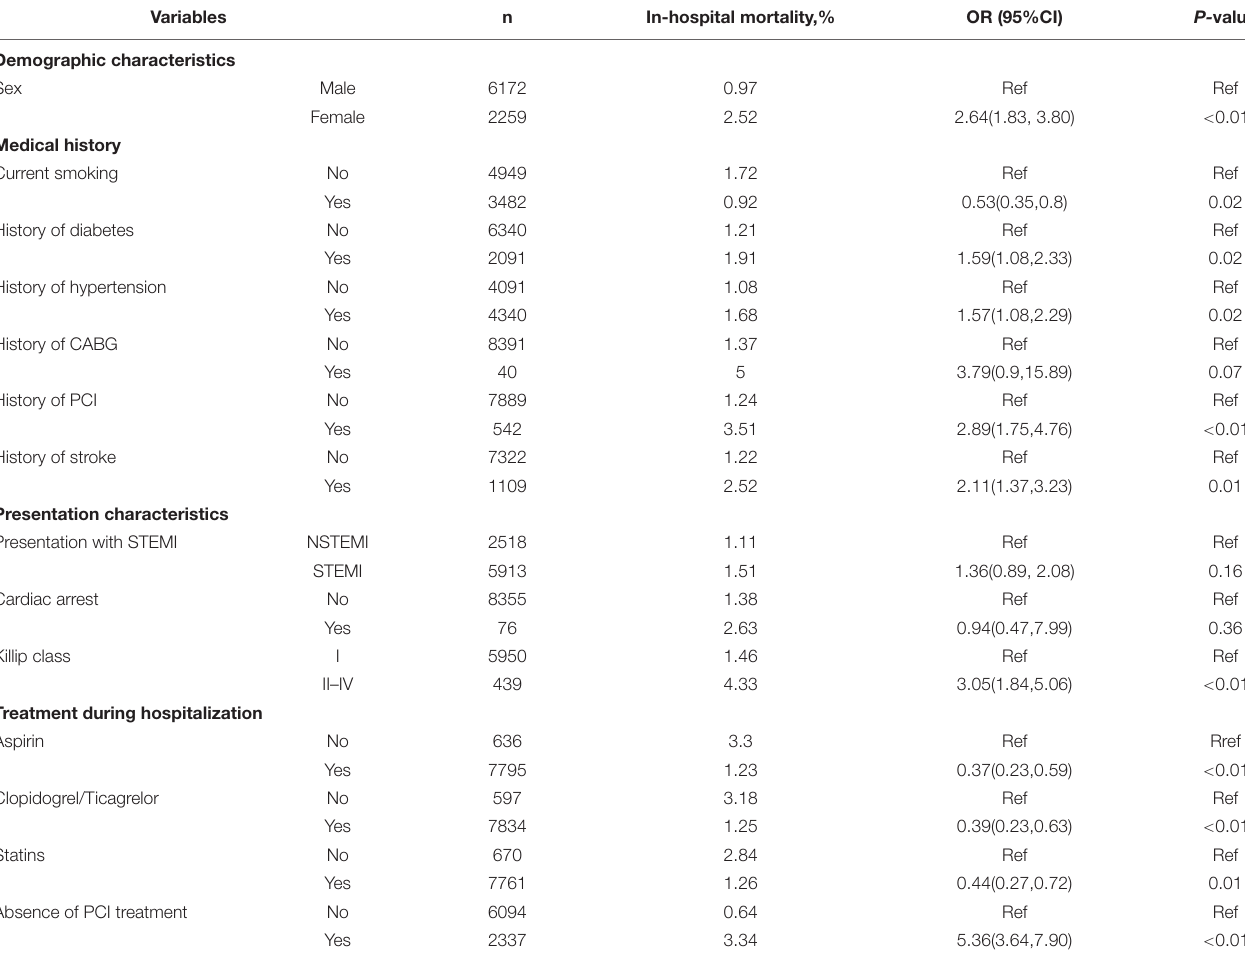
TABLE 3 | Univariate analysis between baseline characteristics (categorical variables) and in-hospital mortality in the training cohort. Variables n In-hospital mortality,% OR (95%CI) P-